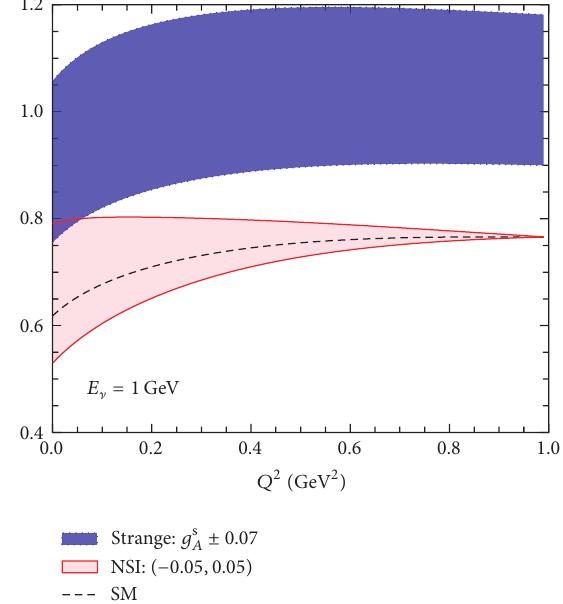
Figure 4: Momentum variation of the cross sections ratio for SM, strange quark, and NSI neutrino-nucleon